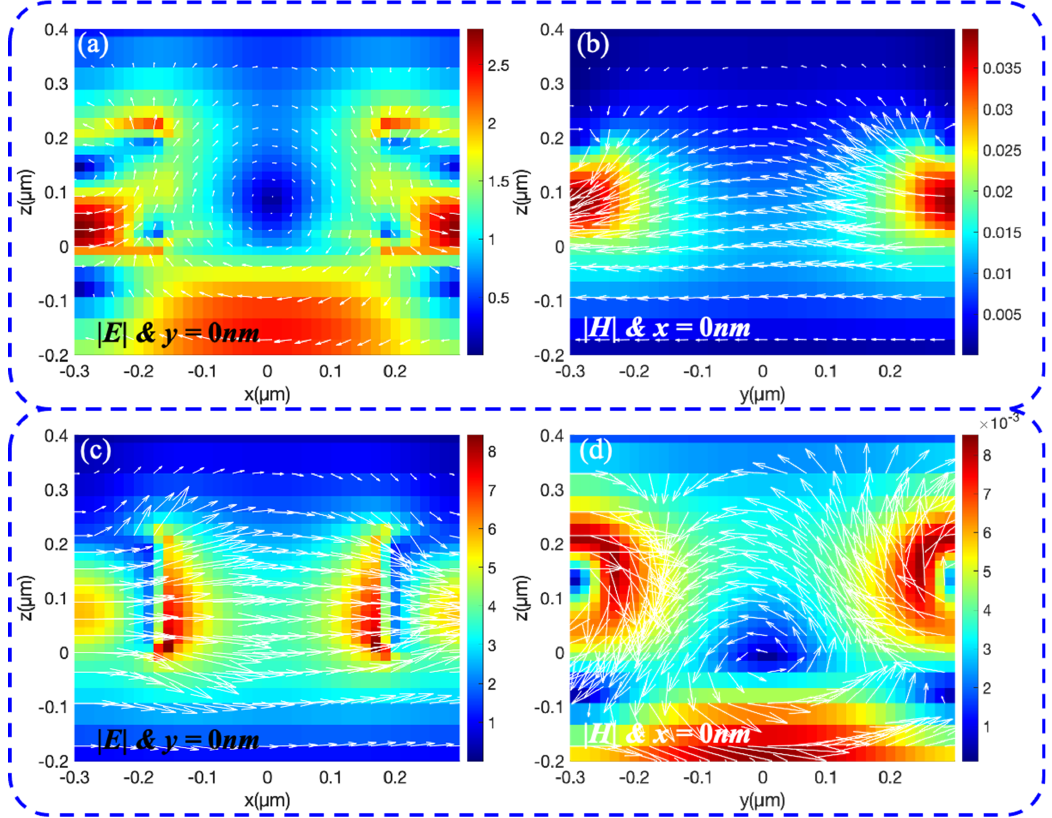
Figure 6. Electric/Magnetic field distributions of the reflection peaks marked in Figure 5b: ( a ) Normalized electric field distribution at λ = 1.16 µm on the x - z plane with y = 0; ( b ) Normalized magnetic field distribution at λ = 1.116µm on the y - z plane with x = 0. ( c ) Normalized electric field distribution of λ = 1.305 µm on the x - z plane with y = 0; ( d ) Normalized magnetic field distribution of λ = 1.305 µm on the y - z plane with x = 0.